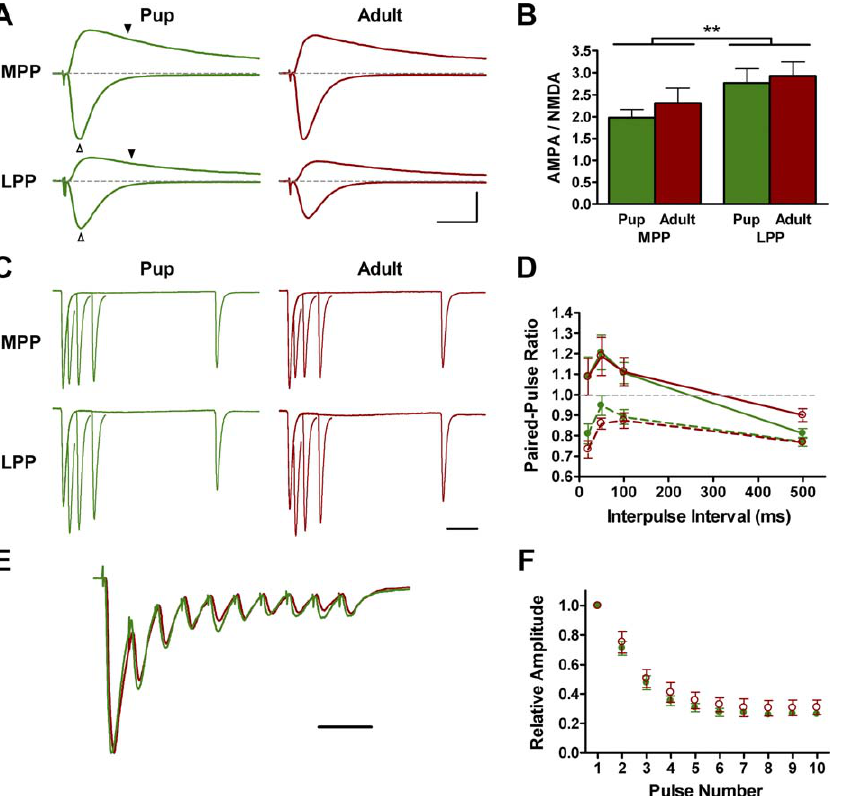
Figure 3. Short-Term Plasticity of Entorhinal Glutamatergic Afferents (A) Average EPSCs recorded at V Hold ¼(cid:2) 80 mV (downward deflections) and þ 50 mV (upward deflections) from pup and adult DGCs ( n ¼ 8 to 11) upon stimulation of MPP or LPP. Dashed line indicates zero level. Arrowheads denote time points for quantification of AMPA (open triangles) and NMDA (filled triangles) currents shown in (B). Criteria for AMPA/NMDA quantification are detailed in the Materials and Methods section. Scale bars indicate 20 ms, 100 pA. (B) AMPA/NMDA ratio from pup and adult DGCs ( n ¼ 9 to 13) in response to MPP or LPP stimulation. Two-way ANOVA revealed a significant effect of MPP versus LPP ( p ¼ 0.006), but no significant effect of pup versus adult ( p ¼ 0.63). (C) Averages of EPSCs in response to paired-pulse stimulation of the MPP or LPP delivered at increasing interpulse intervals (20, 50, 100, and 500 ms). Traces are averages of 7–14 cells aligned and normalized to the first EPSC. Stimulation artifacts and late decay phases of the second EPSC were removed for clarity. Scale bar indicates 100 ms. (D) Paired-pulse ratio as a function of interpulse interval for the experiments shown in (C). Two-way ANOVAs revealed a significant effect of interpulse interval for MPP (dashed lines, p , 0.0001) and LPP (solid lines, p , 0.0001), but no significant effect of pup (green lines, solid circles) versus adult (red lines, open circles) for either MPP ( p ¼ 0.073) or LPP ( p ¼ 0.72) stimulation ( n ¼ 9 to 14) (E) Example of EPSCs from a pup (green) and an adult DGC (red) in response to MPP stimulation (ten pulses, 50 Hz) Traces are normalized to the first EPSC amplitude. Scale bar indicates 40 ms. (F) Relative EPSC amplitudes measured in response to 50-Hz stimulation evoked as shown in (E). No difference was found between pup and adult responses (two-way ANOVA, p ¼ 0.49, n ¼ 10 pups [solid circles], n ¼ 4 adults [open circles]). All recordings were carried out in the presence of 20- l m BMI. Neurons were approximately 18 wk old (pup) and approximately 13 wk old (adult). All plots depict mean 6 SEM. DOI: